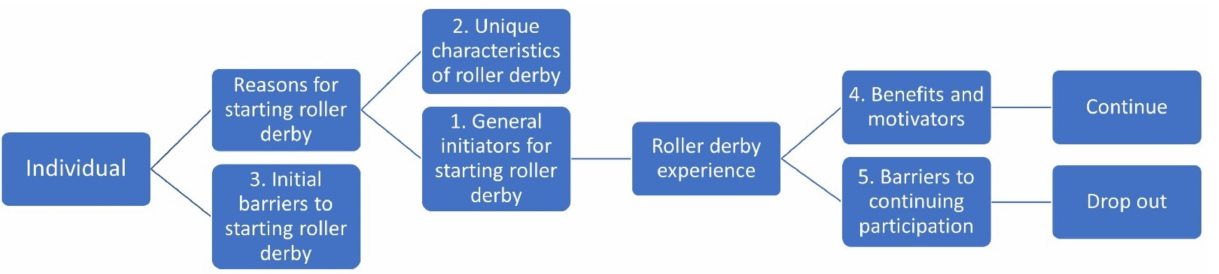
Figure 2. Conceptual framework of super-ordinate themes 1–5: “Individual Journeys through the Roller Derby